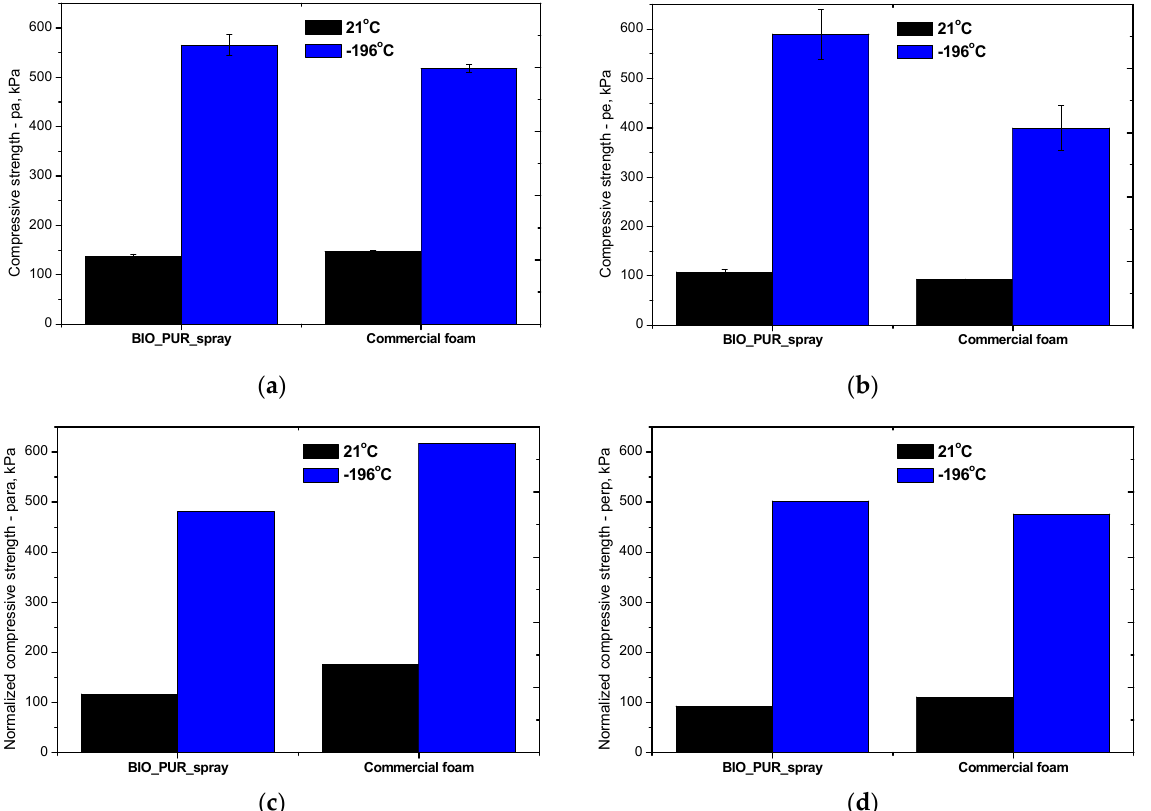
Figure 5. The compressive strength ( a , b ) and normalized compressive strength ( c , d ) of spray PUR bio-foams obtained on an industrial scale measured in two directions: perpendicular and parallel to the foam rise